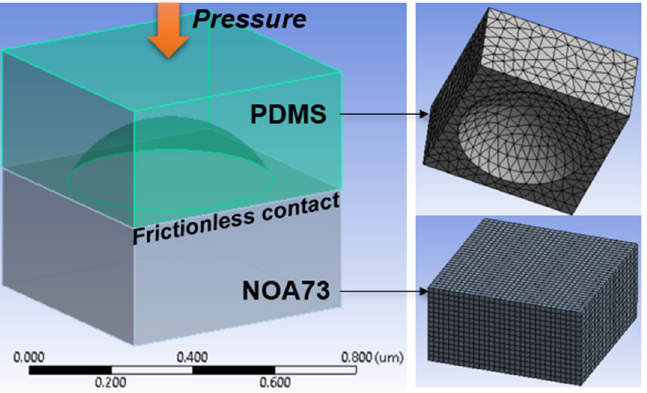
Figure 3. Geometry and finite element mesh models of the PDMS nanocup cavity and NOA73 film. The interface between them was modeled to be frictionless.